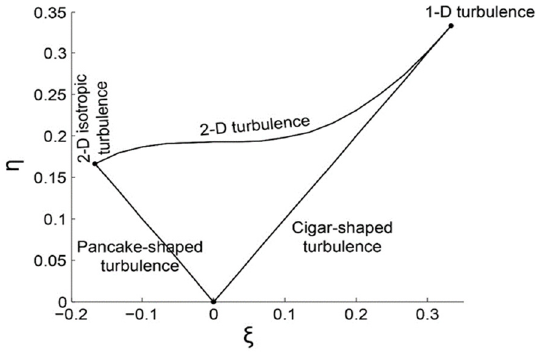
Figure 18. A schematic shape of a Lumley triangle in the η (2nd invariant) and ξ (3rd